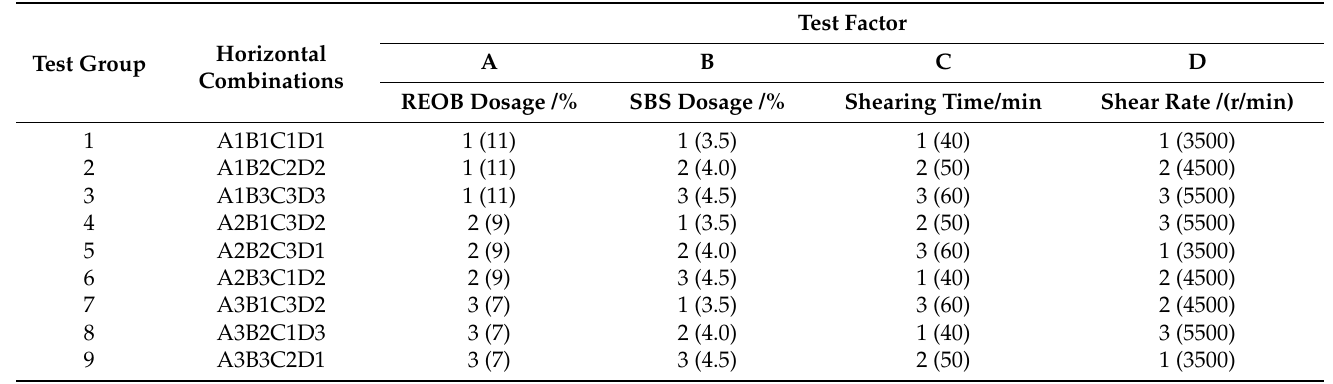
Table 4. Orthogonal test design